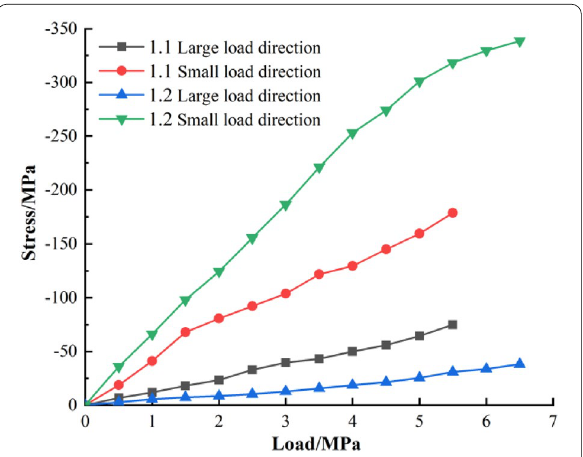
Fig. 15 Load–hoop stress relationship curve of inner bars.